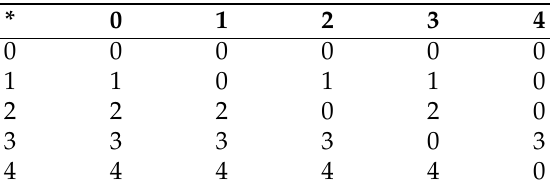
Table 3. Cayley table for the binary operation “ ∗ ”.